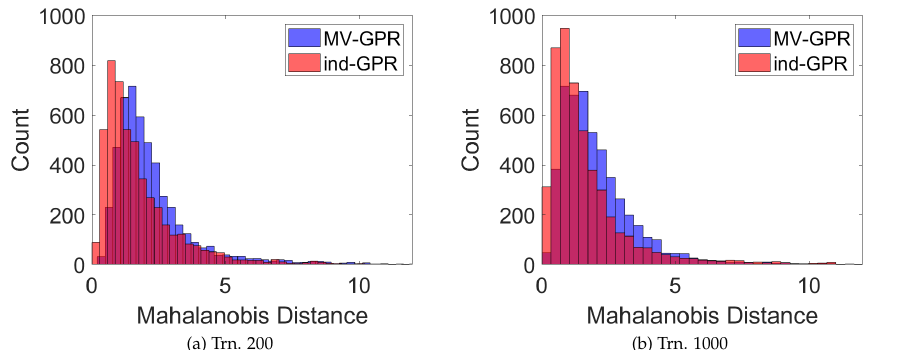
Figure 8. The Mahalanobis distance from the true state to the GPR-predicted mean given the GPR- predicted covariance ( a ) 200 and ( b ) 1000 given perfect RA and DEC